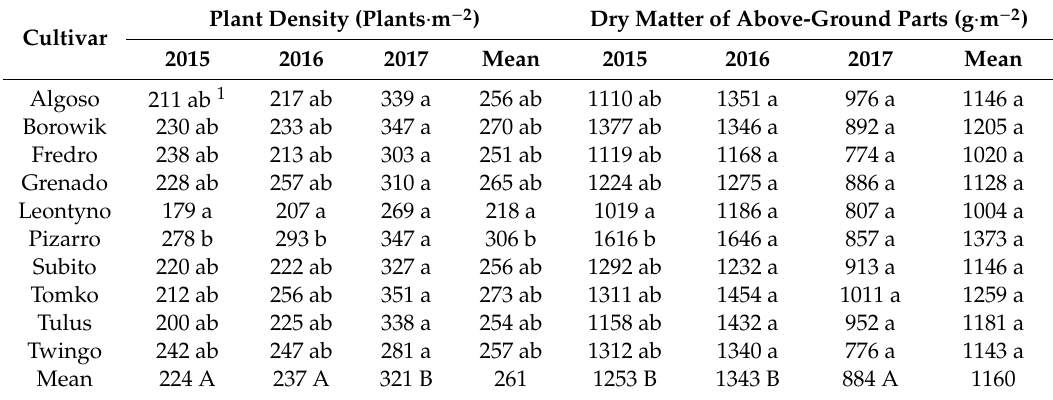
Table 5. Plant density and dry matter of triticale cultivars grown in an organic system at the dough stage. Cultivar